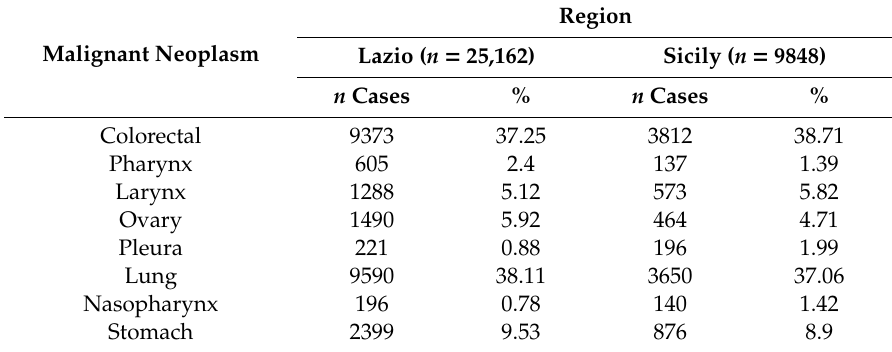
Table 5. Distribution of malignant neoplasm in occupational cancer monitoring (OCM) data for Lazio and Sicily.